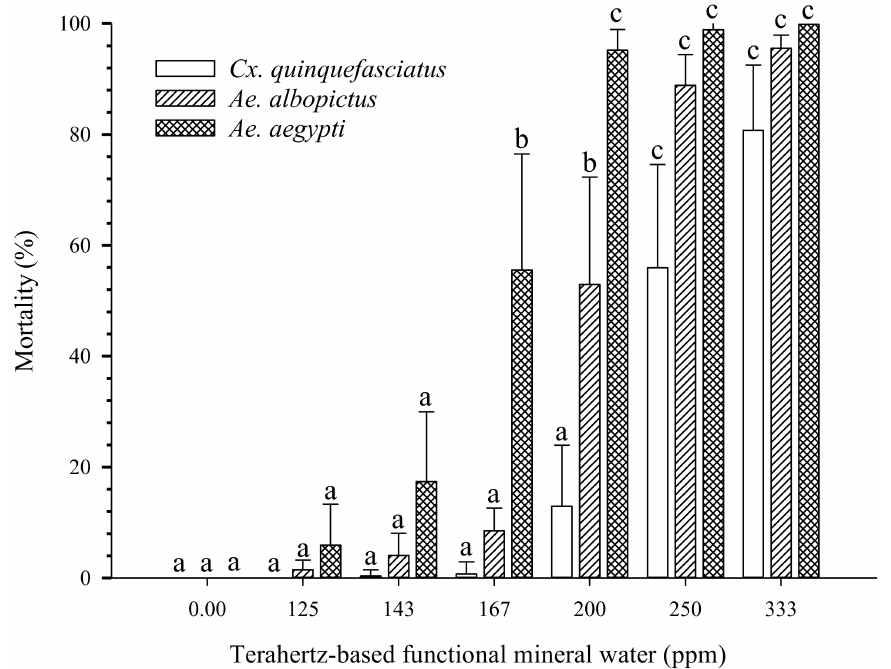
Figure 1. Effects of terahertz-based functional mineral water on mosquito larvae. The third instar larvae were exposed to various concentrations of terahertz-based functional mineral water, and the mortality of the larvae was recorded after 24 h. Data are presented as mean ± SE values from at least three independent experiments, and different letters indicate significant differences ( p < 0.05) between different concentrations at each species. Table 1. Toxicity of terahertz-based functional mineral water to larvae of vector mosquitoes. Aedes aegypti Aedes Albopictus Culex